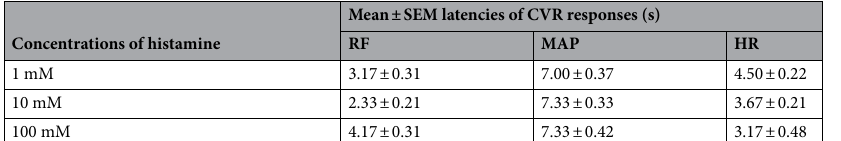
Table 2. Mean ± SEM values of latencies of cardiorespiratory (CVR) responses after instillation of different concentrations of histamine. RF respiratory frequency, MAP mean arterial pressure; HR heart rate. The latencies of MAP responses are significantly different as compared with the RF and HR responses for all concentrations of histamine [ P < 0.05, Unpaired